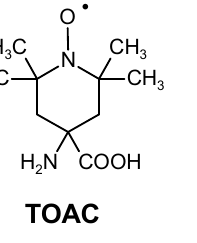
Figure 1. Molecular structure of TOAC and amino acid sequence of trichogin GA IV ( n -Oct, octanoyl; Aib, α -aminoisobutyric acid; Lol, leucinol).